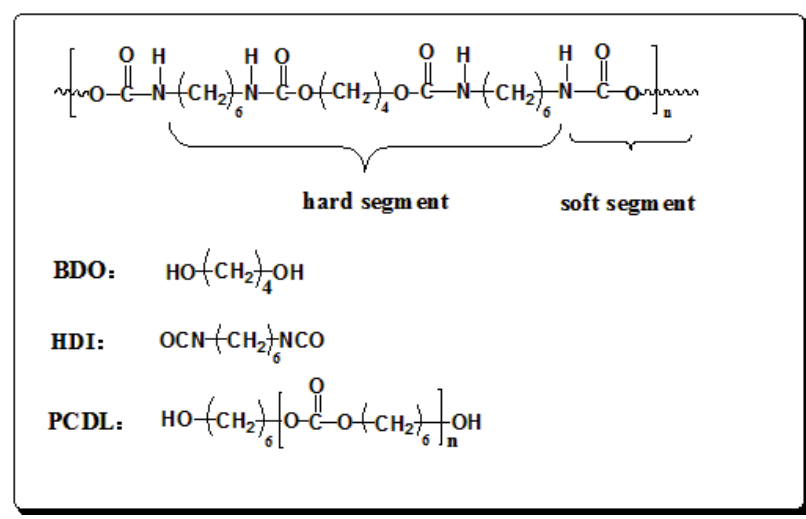
Figure 1. The chemical structures of the components in the polyurethanes.